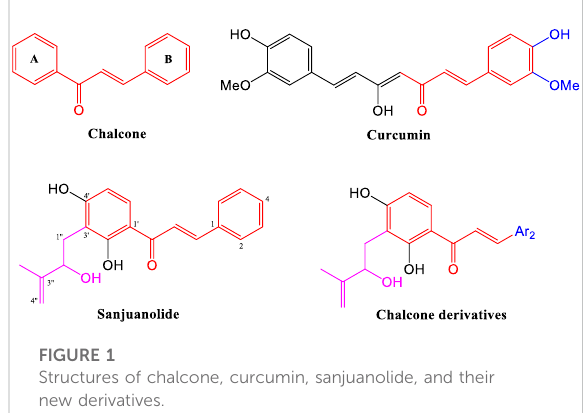
Structures of chalcone, curcumin, sanjuanolide, and their new